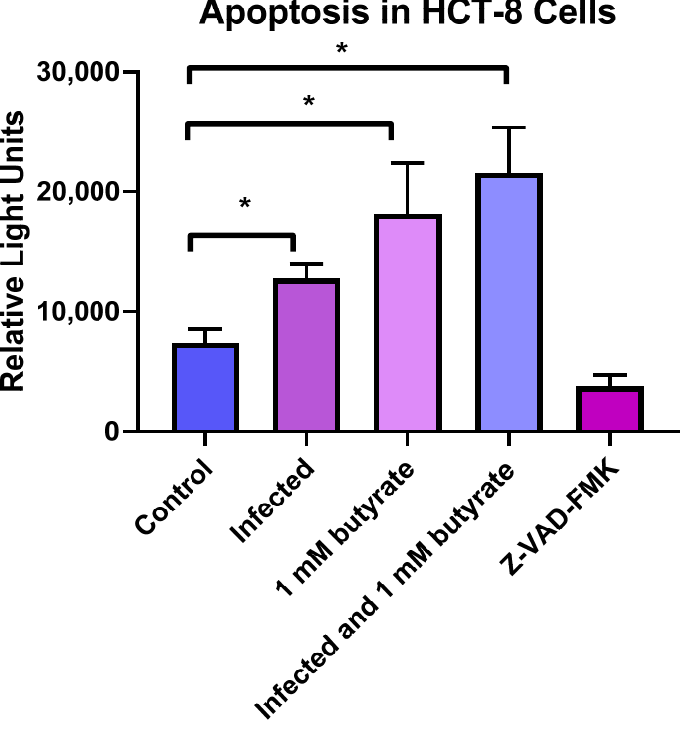
Figure 2. Amount of apoptosis in C. parvum -infected and butyrate-treated cells. HCT-8 cells were infected with C. parvum and/or treated with 1 mM of butyrate for 24 h, after which the cells were analyzed for percent apoptosis. Control wells (uninfected, untreated) were compared with treated wells and infected wells. The peptide Z-VAD-FMK, which inhibits apoptosis, served as a positive control. Values are means ± SEM, n = 4. * Different from control, p < 0.05.